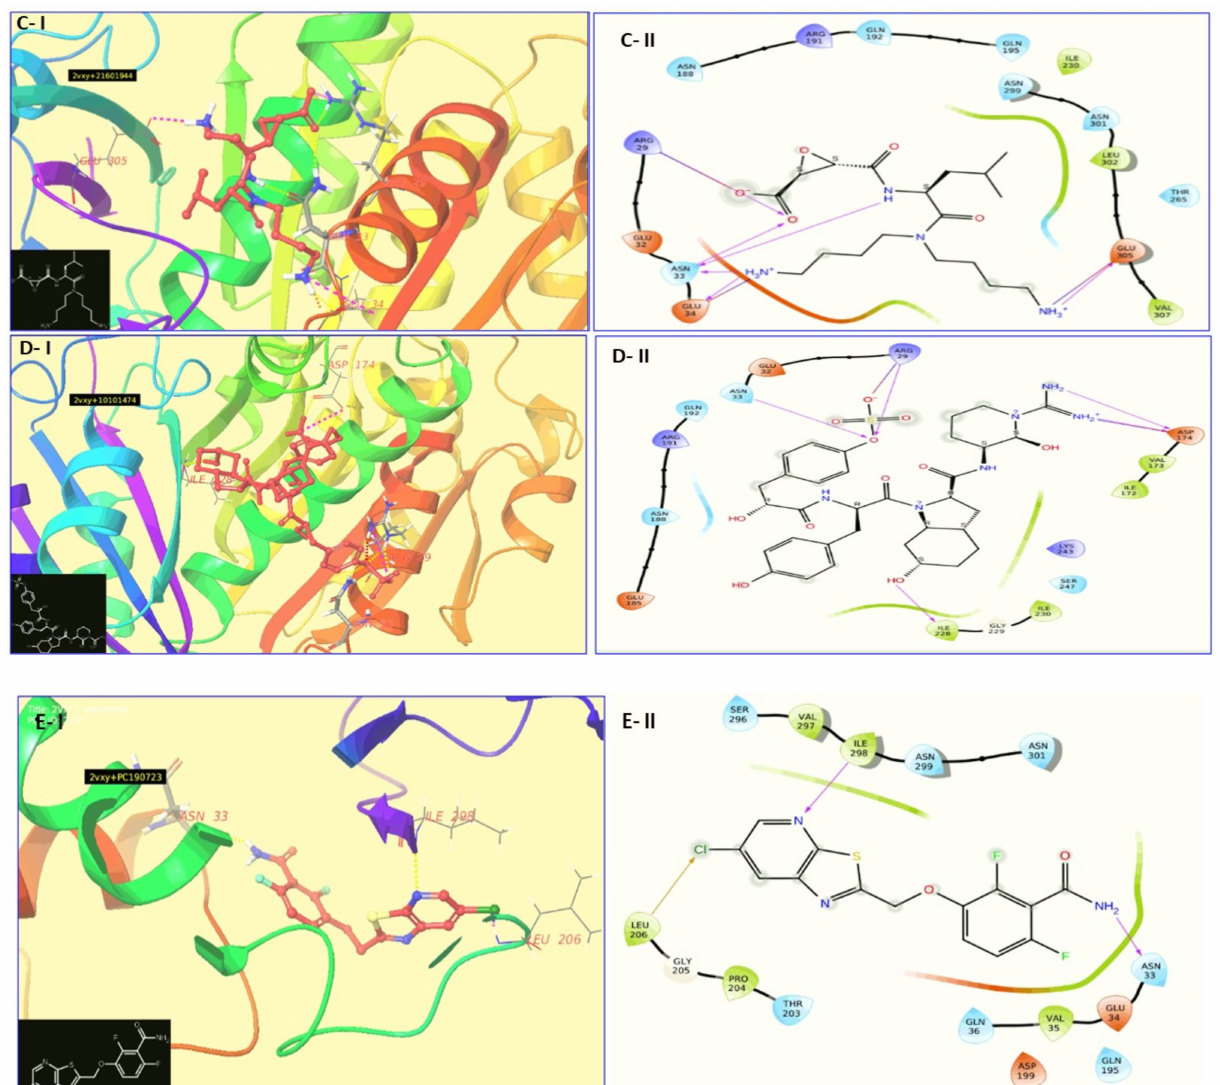
Figure 4. The 2D and 3D diagrams of docking poses. ( A-I ) 3D interaction diagram of Alpha dimor- phecolic acid (5312830) with Fts-Z protein.; ( A-II ) 2D interaction diagram of Alpha dimorphecolic acid (5312830) with Fts-Z protein.; ( B-I ) 3D interaction diagram of Aphanorphine (189594) with Fts-Z pro- tein. ( B-II ) 2D interaction diagram of Aphanorphine (189594) with Fts-Z protein.; ( C-I ) 3D interaction diagram of Circinamide (21601944) with Fts-Z protein. ( C-II ) 2D interaction diagram of Circinamide (21601944) with Fts-Z protein.; ( D-I ) 3D interaction diagram of Aeruginosin 102 A (10101474) with Fts-Z protein. ( D-II ) 2D interaction diagram of Aeruginosin 102 A (10101474) with Fts-Z protein.; ( E-I ) 3D interaction diagram of PC190723 (25016417) with Fts-Z protein. ( E-II ) interaction diagram of PC190723 (25016417) with Fts-Z